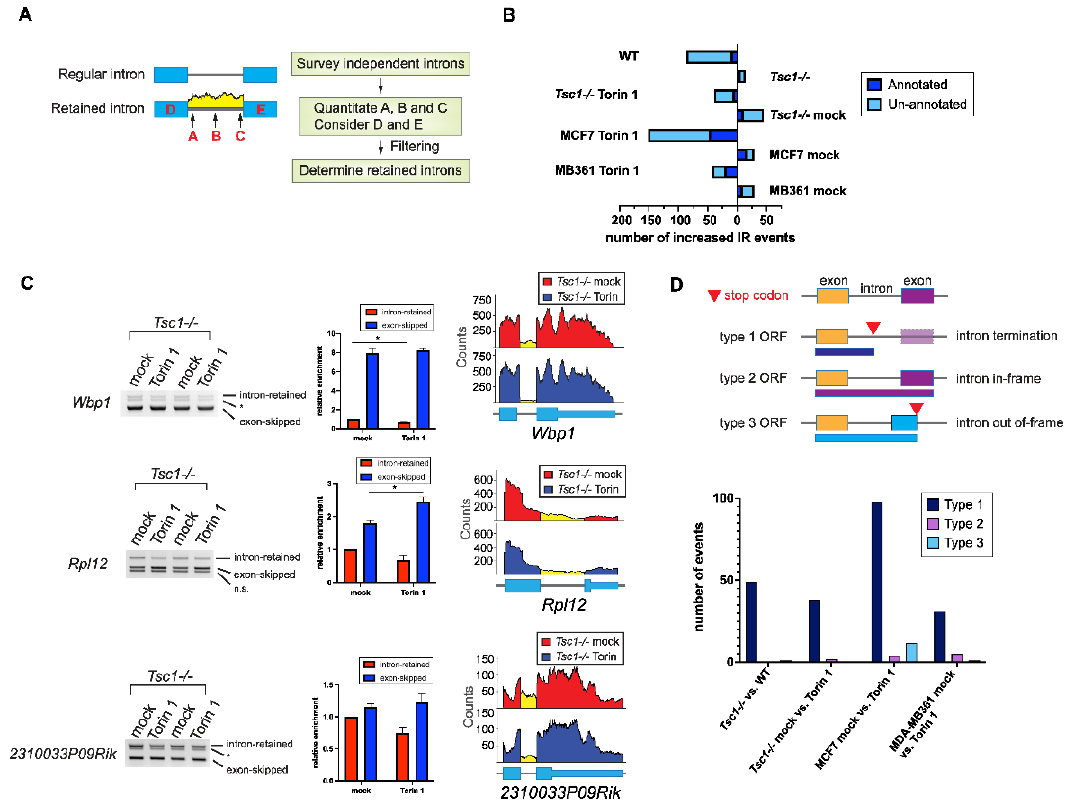
Figure 3. Computational pipeline uncovers novel, unannotated differentially expressed intron- retained transcripts regulated by mTOR signaling. ( A ) A flowchart demonstrating the computational pipeline to identify unannotated retained introns. ( B ) Analyses of the total differentially intron-retained transcripts (both annotated found by AS-Quant and the unannotated) by mTOR signaling in the four pairs of RNA-sequencing datasets. ( C ) RT-PCR gel electrophoresis of select transcripts with differential intron retention found in Tsc1-/- MEFs mock vs. Torin 1 treatment. The faint band marked by * could come from another isoform with cryptic splice site usage or another unknown novel transcript. Semi-quantification of the band intensities was performed using densitometry and statistical significance between mock and treatment samples was determined by Student’s t -test. * denotes significant with p -value < 0.05. ( D ) Count of the different translational outcomes by intron-retention in the four pairs of RNA-sequencing datasets.